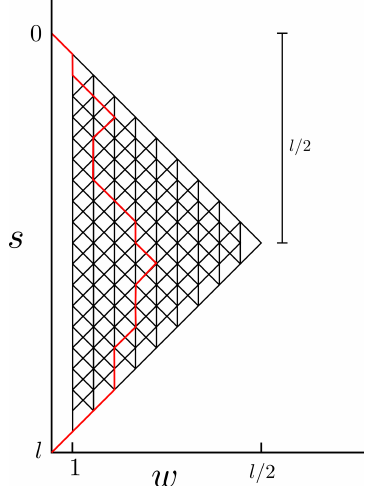
Figure 4. Conceptual diagram showing all possible paths of the width function for a watershed of length, l . The red line is one re- alization. The ensemble of paths is symmetrical about l/ 2, and the boundary condition is illustrated by no paths reaching w = 0 before l